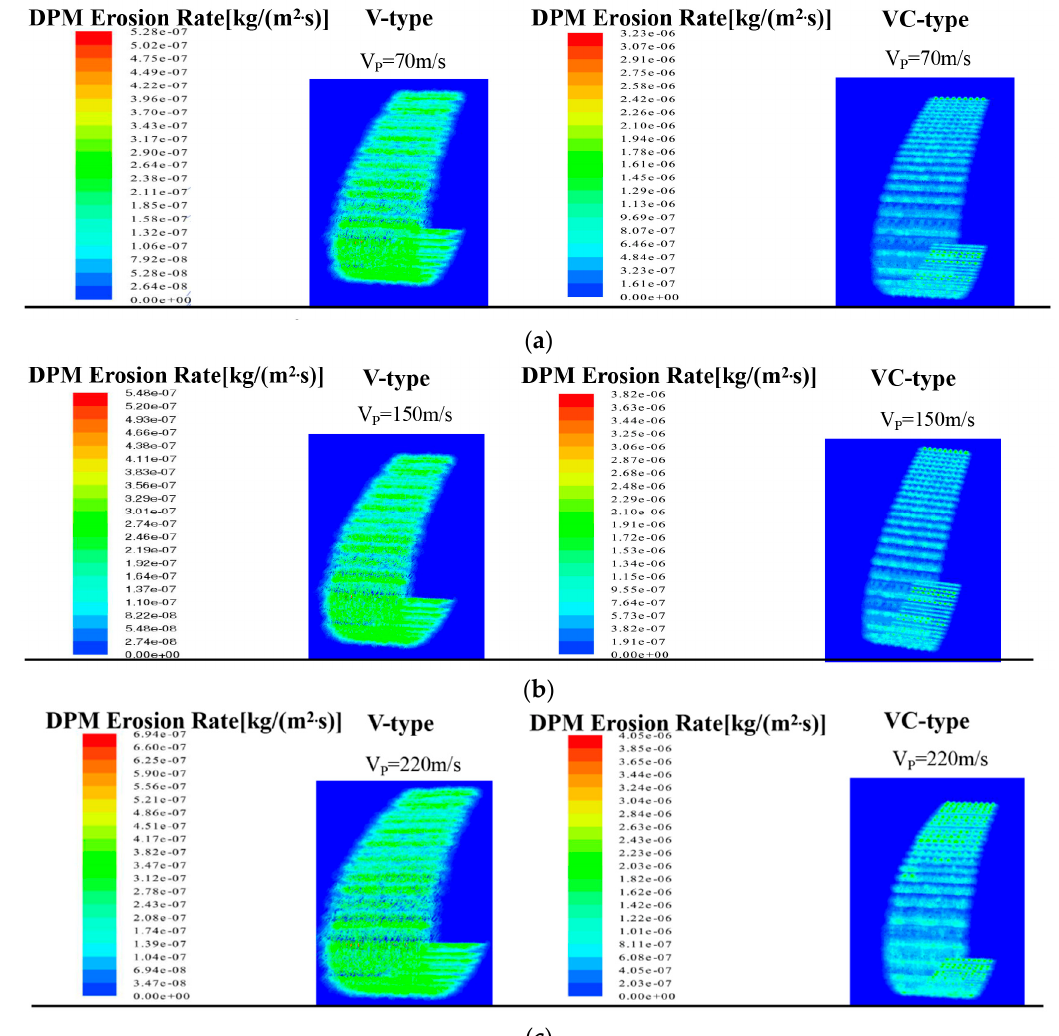
Figure 13. Three-dimensional erosion rates of the two bionic coatings at 0° angle of attack: ( a ) V P = 70 Figure13. Three-dimensionalerosionratesofthetwobioniccoatingsat0 ◦ angleofattack: ( a ) V P = 70m / s; m/s; ( b ) V P = 150 m/s; ( c ) V P = 220 m/s. ( b ) V P = 150 m / s; ( c ) V P = 220 m /